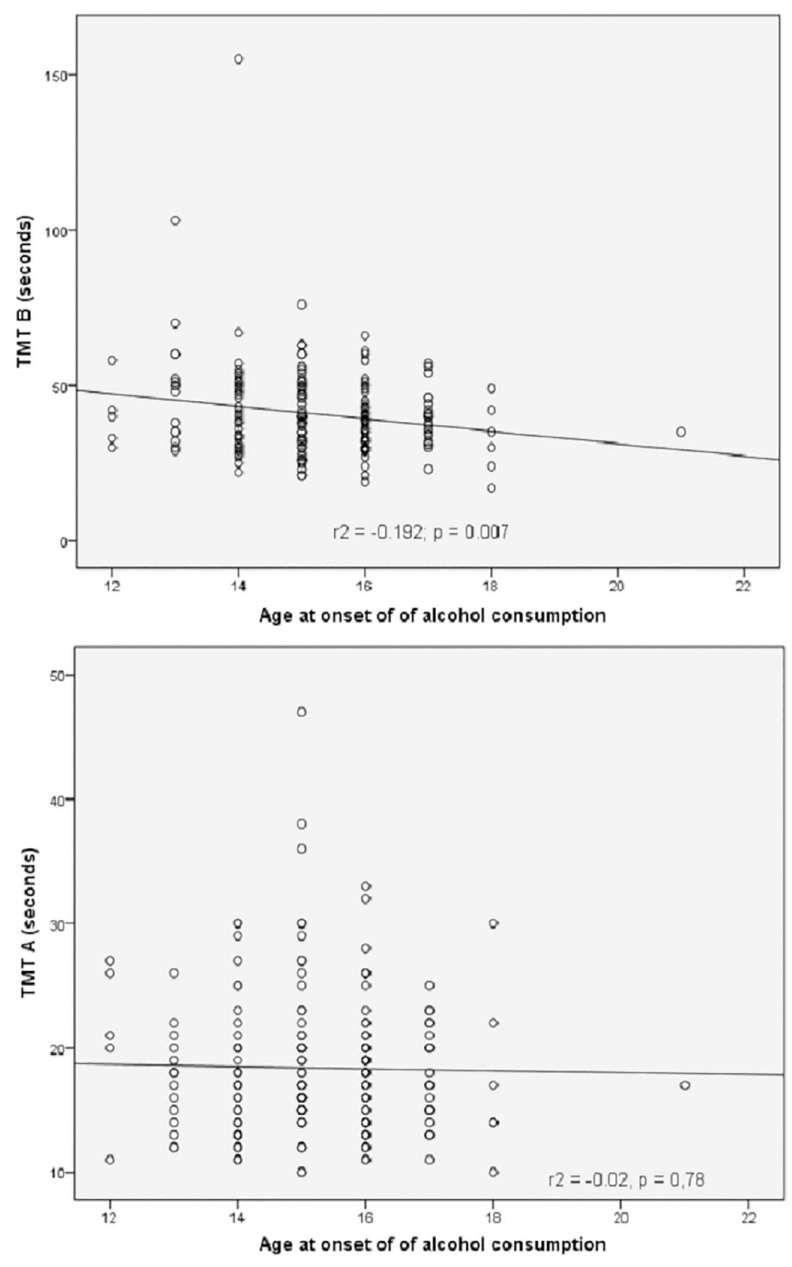
Fig 1. Correlation between TMT A and TMT B with age at onset of alcohol